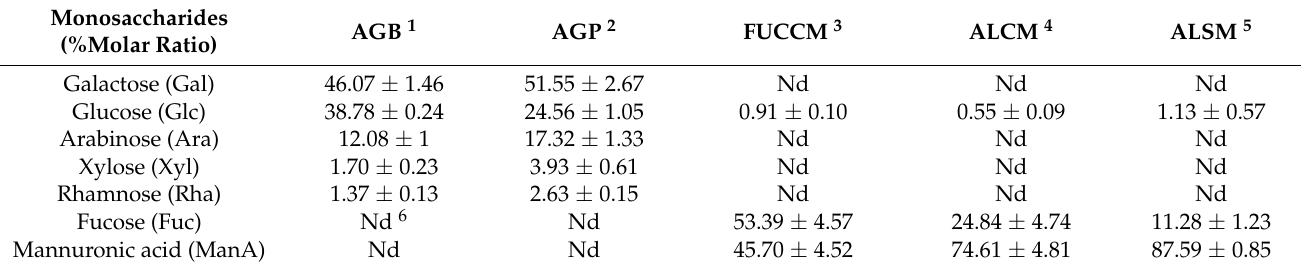
Table 3. GC/MS–EI analysis of different saccharide extracts.